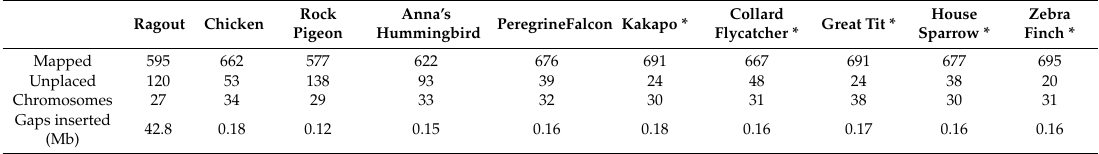
Table 2. Comparison of assemblies of R. melanosticta based on multiple references (first column: Ragout [39], references marked by an asterisk) and single reference genome assembly (Chromosomer [30]) corresponding to column names. Mapped refers to number of sca ff olds mapped to genome (Ragout) or the sum of mapped and unlocalized (mapped to chromosome but with final position undefined) sca ff olds in Chromosomer. The references are listed from furthest to closest in phylogenetic distance (passerines are listed alphabetically as they are equidistant to